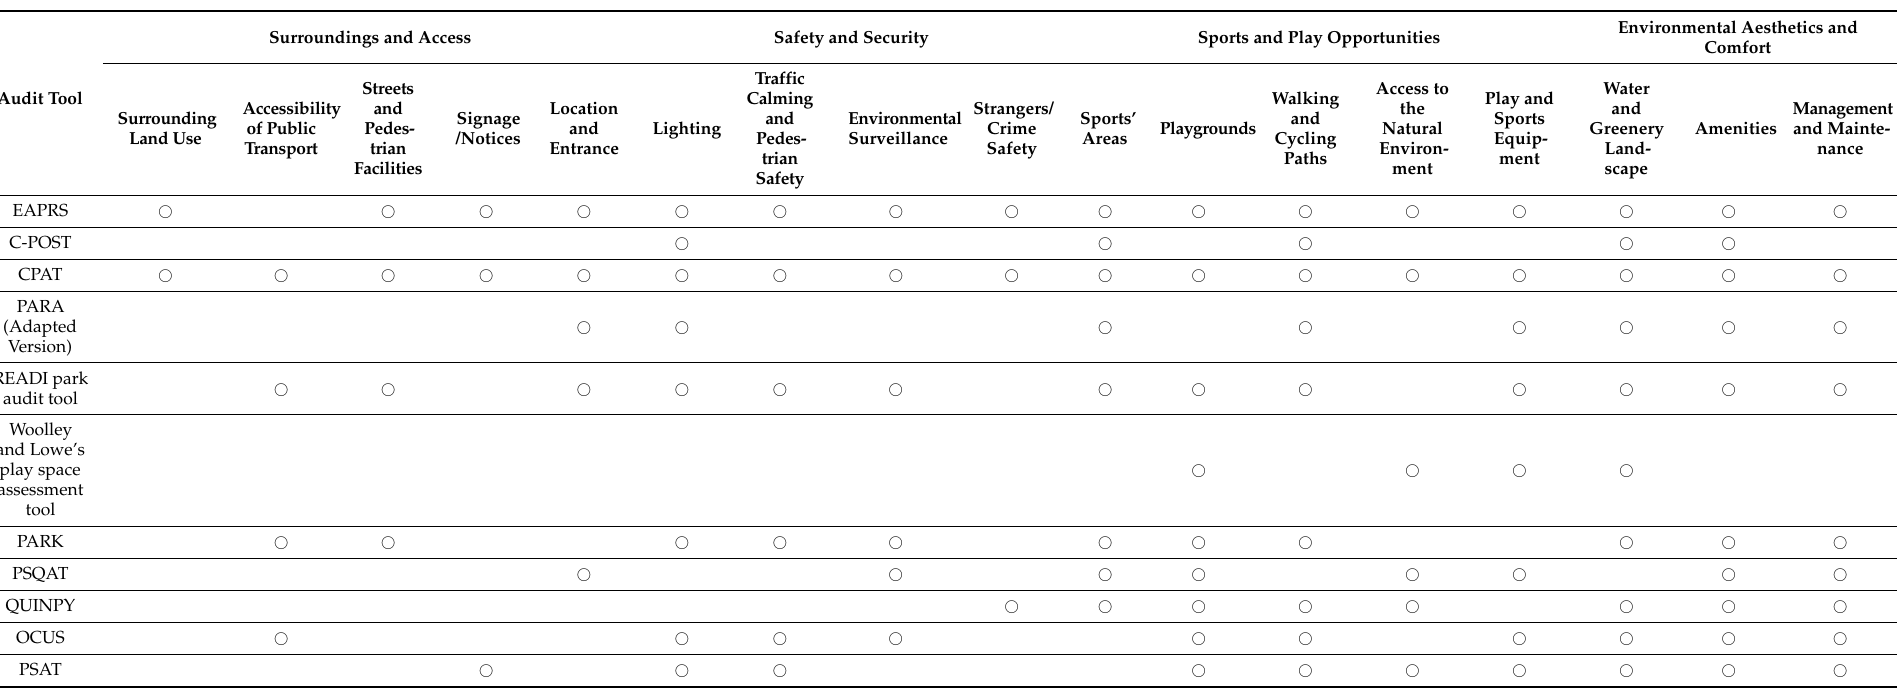
Table 4. The relationship between audit tool items and four key